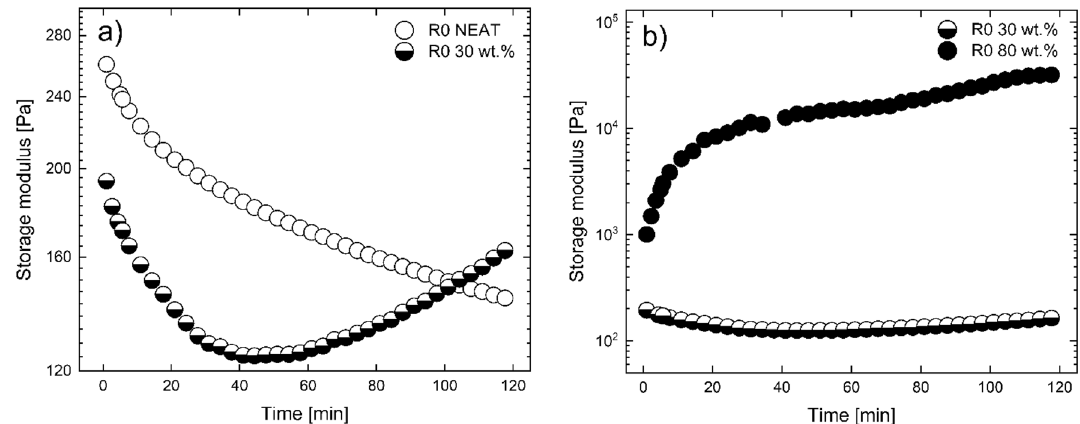
Figure 7. Dynamic time sweeps for ( a ) R0 PURE open circles and R0 30 wt% half open circles and ( b ) R0 30 wt.% half open circles and R0 80 wt.% filled